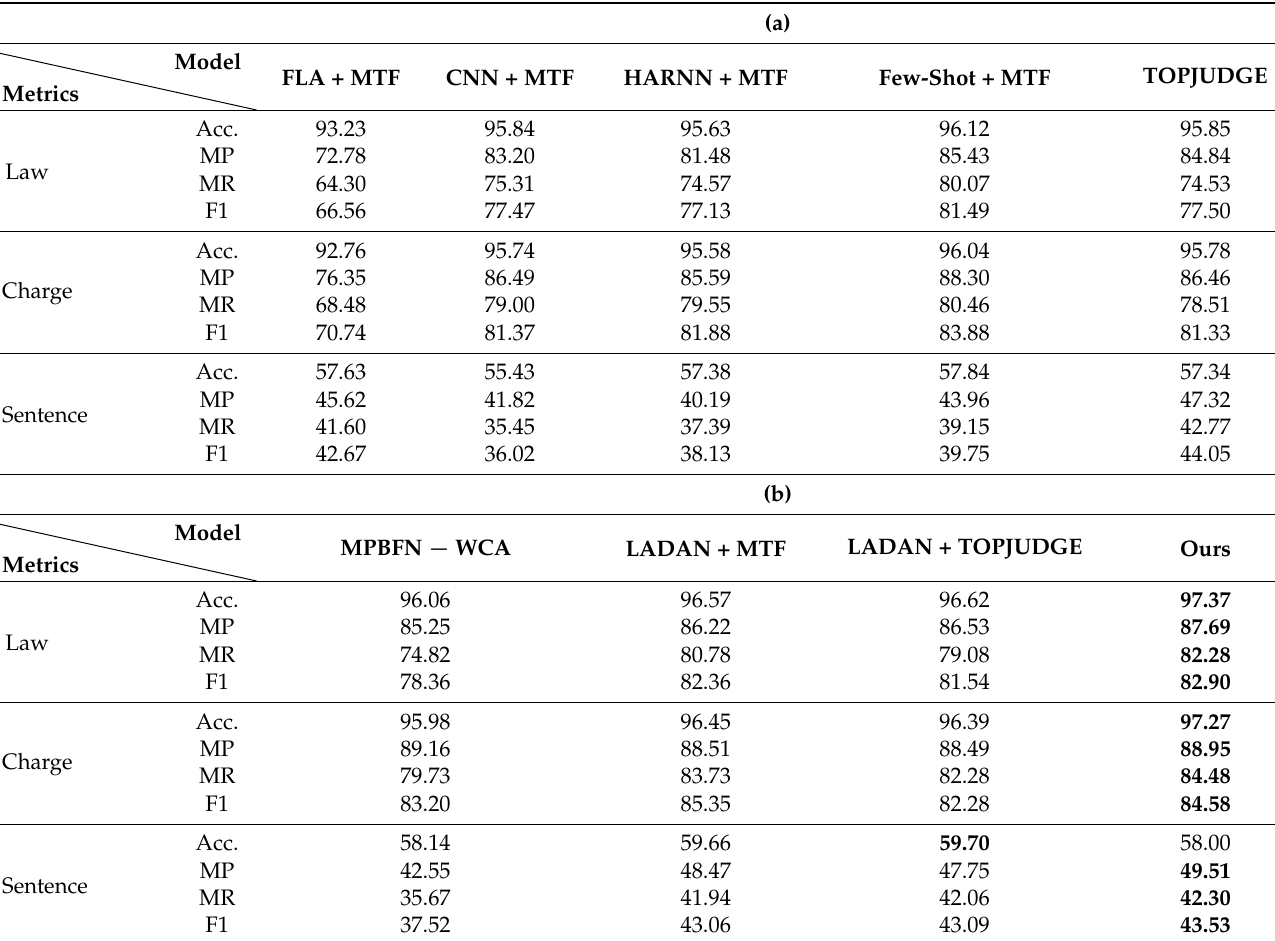
Table 6. Results of judgment prediction on CAIL-big in comparative experiments (%) (a) and (b).